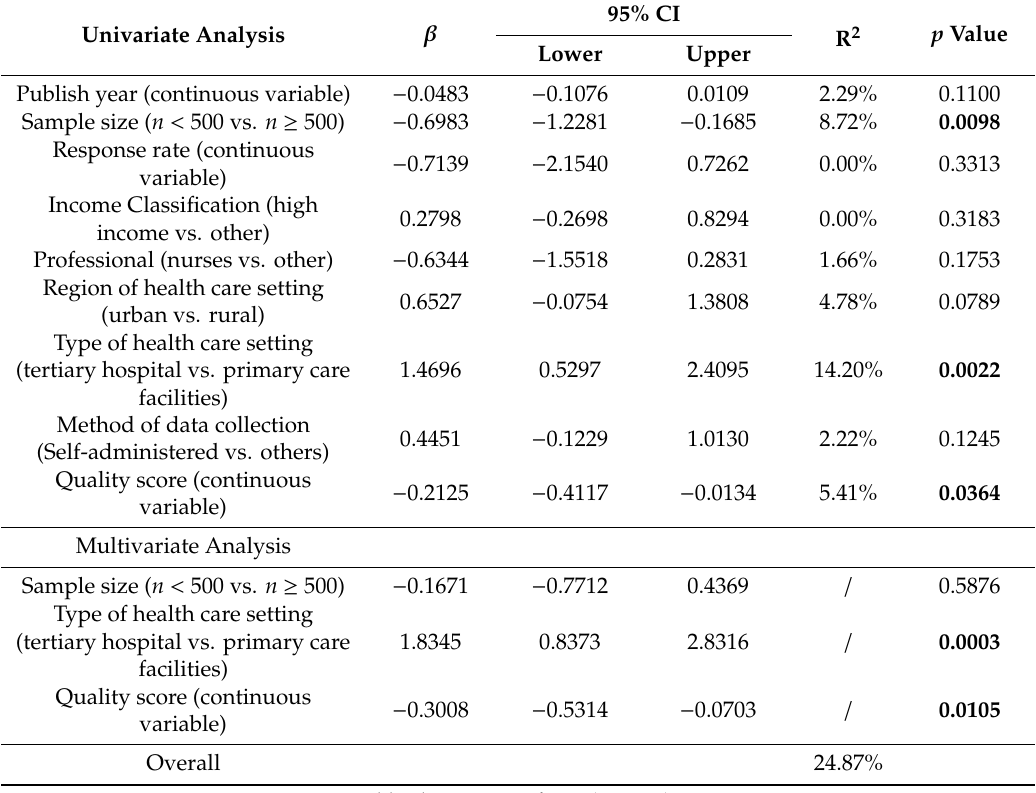
Table 3. Meta-regression analyses of the e ff ects of potential moderators.